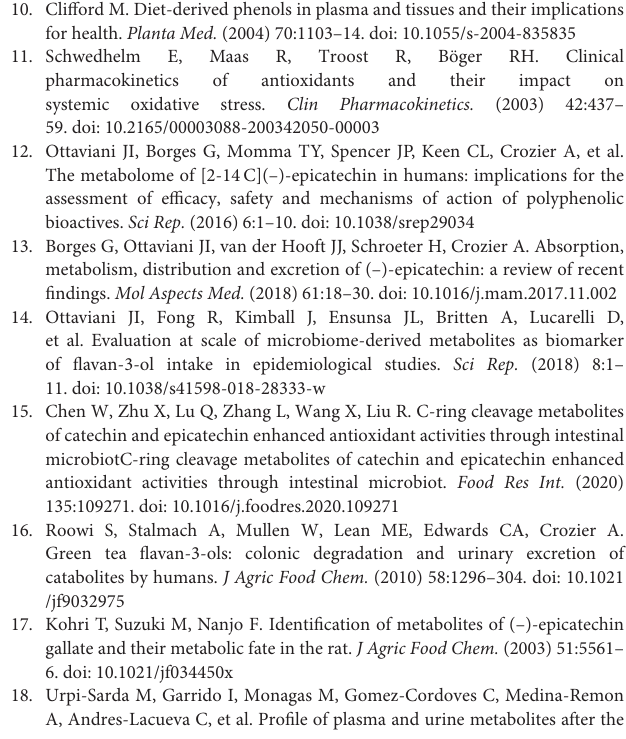
( Supplementary Figure S1 ). One-way ANOVA for U2OS Nrf2 CALUX assay ( Supplementary Figure S2 ). network analysis ( Supplementary Figure S4 ). Relative RNA and protein levels in Caco-2 cells after exposure to EC or 3,4-diHPV ( Supplementary Figure S5 ). identified and quantified in Hepa1c1c7 and Caco-2 cells ( Supplementary Tables S1, S2